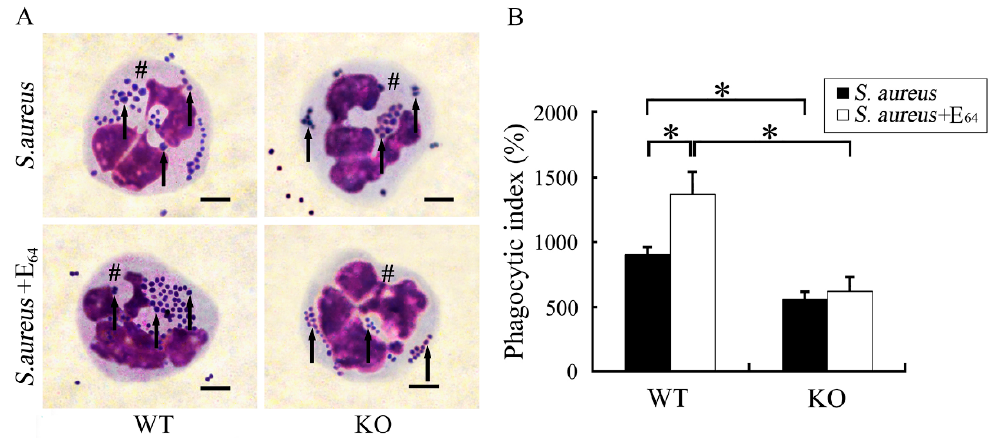
Figure 5. PMN phagocytosis of S. aureus is promoted by surfactant protein D (SP-D), and S. aureus cysteine protease diminished SP-D activity. ( A ) PMNs shown are from tear fluid after inoculation with S. aureus or S. aureus with E64 (cysteine protease inhibitor). ( B ) Phagocytic index (PI) from PMNs in the tear fluid of infected wild-type (WT) and SP-D KO mice. #, PMNs; Arrows, S. aureus . This figure is reproduced under a Creative Commons License from © 2015 PLoS One [100].